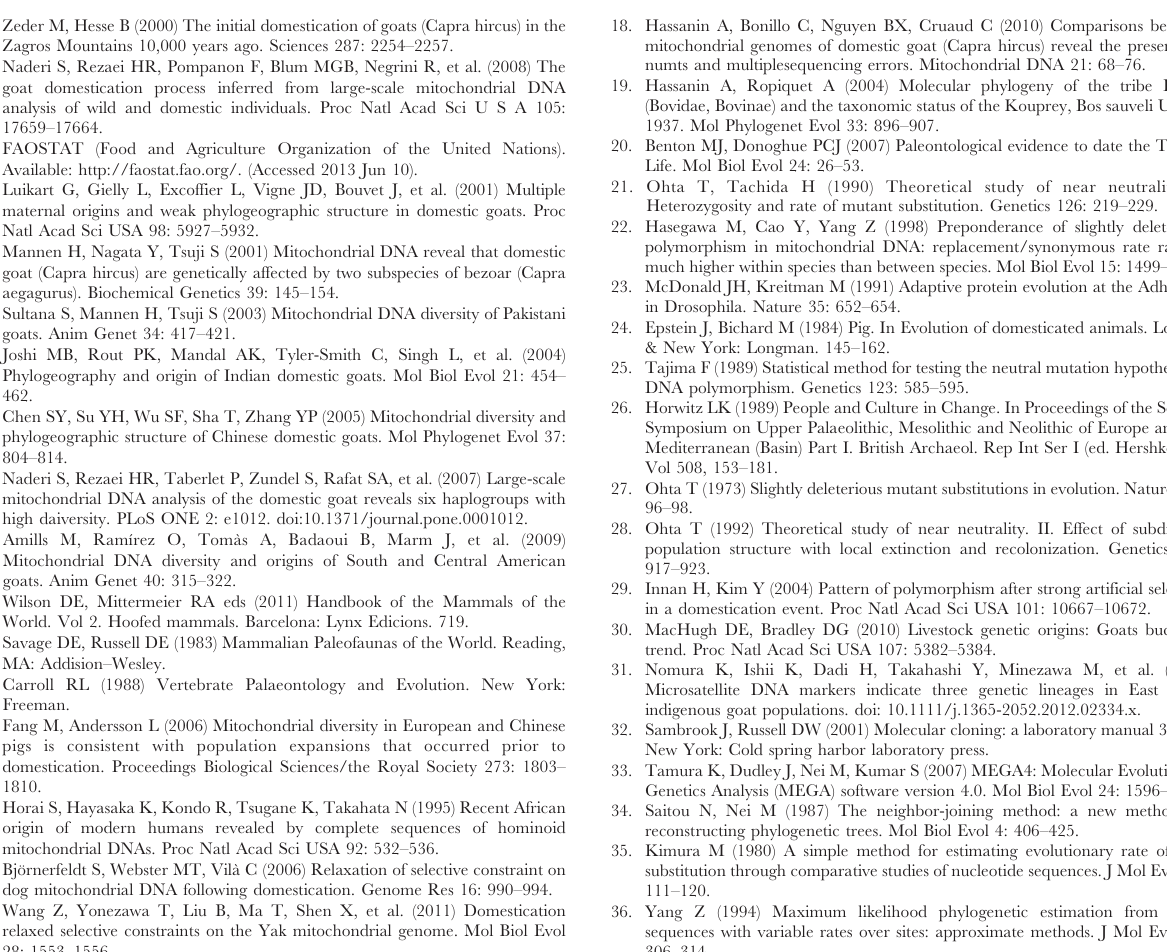
deep branches (b). The branch lengths are proportional to numbers of codon substitutions. Table S1 Tajima’s D of each haplogroup based on the D-loop sequences of the wild bezoar. Table S2 PCR primer pairs used for amplification of mitochondrial protein coding region and HV1 region. Table S3 List of the variant